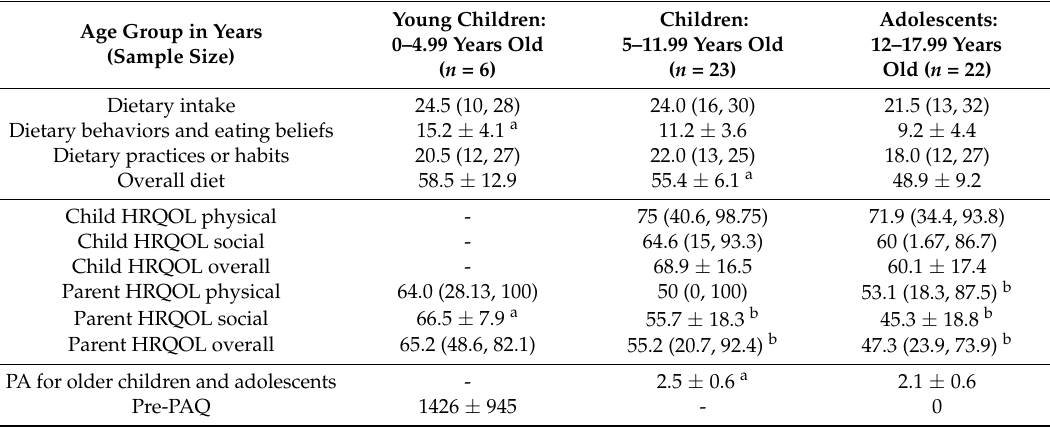
Table 2. Dietary, physical activity and health-related quality of life scores by age groups. Age Group in Years (Sample Size)